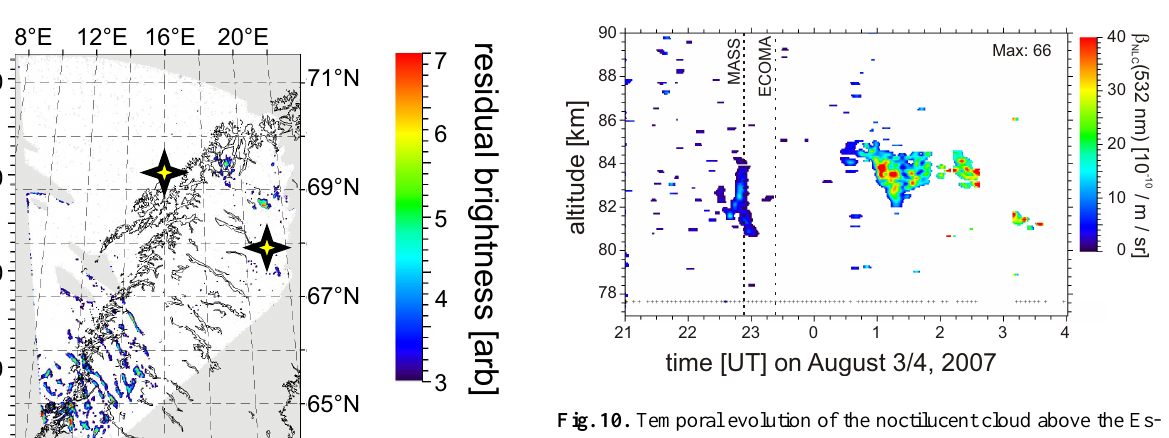
Fig. 10. Temporal evolution of the noctilucent cloud above the Es- range on 3/4 August 2007 as measured by the University of Bonn